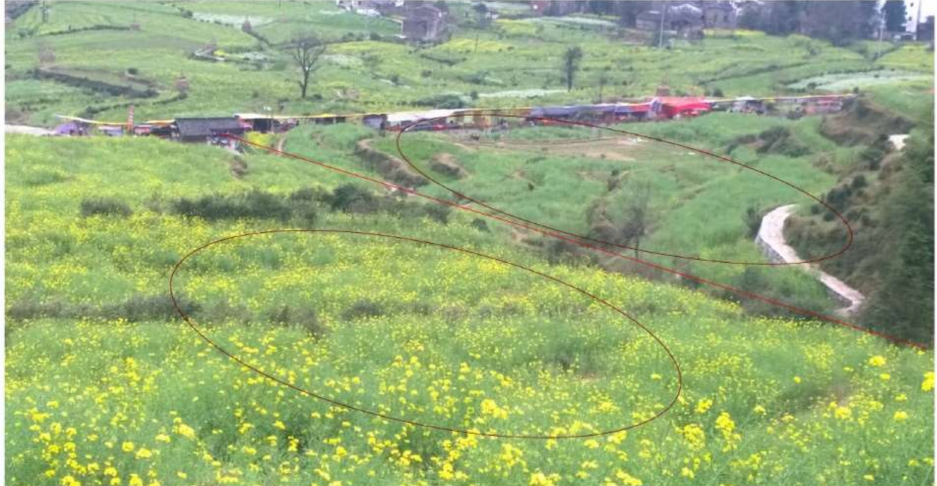
Figure 2. Prolonging the flowering period by mixing early-flowering cultivars with a late-flowering cultivar. The circle to the left of the red line indicates mixed sowing of rapeseed from early flowering cultivars and late flowering cultivar, which shows longer flowering period by at least five days than the normal cultivar shown in the circle to the right of the red